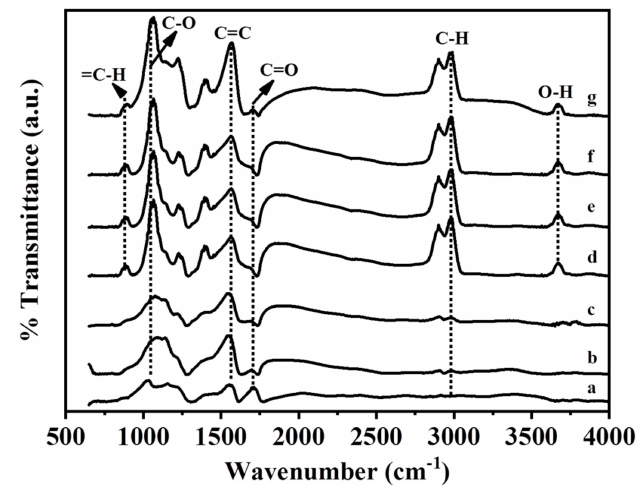
Figure 5. Fourier-transform infrared spectra analysis. ( a ) GO as the control, ( b ) 5.34% Ag / rGO, ( c ) 7.49% Ag / rGO, ( d ) 6.85% ZnO / rGO, ( e ) 16.45% ZnO / rGO, ( f ) 3.47 / 34.91%Ag / ZnO / rGO, and ( g ) 7.08 / 15.28% Ag / ZnO / rGO. Data are representative of two separate